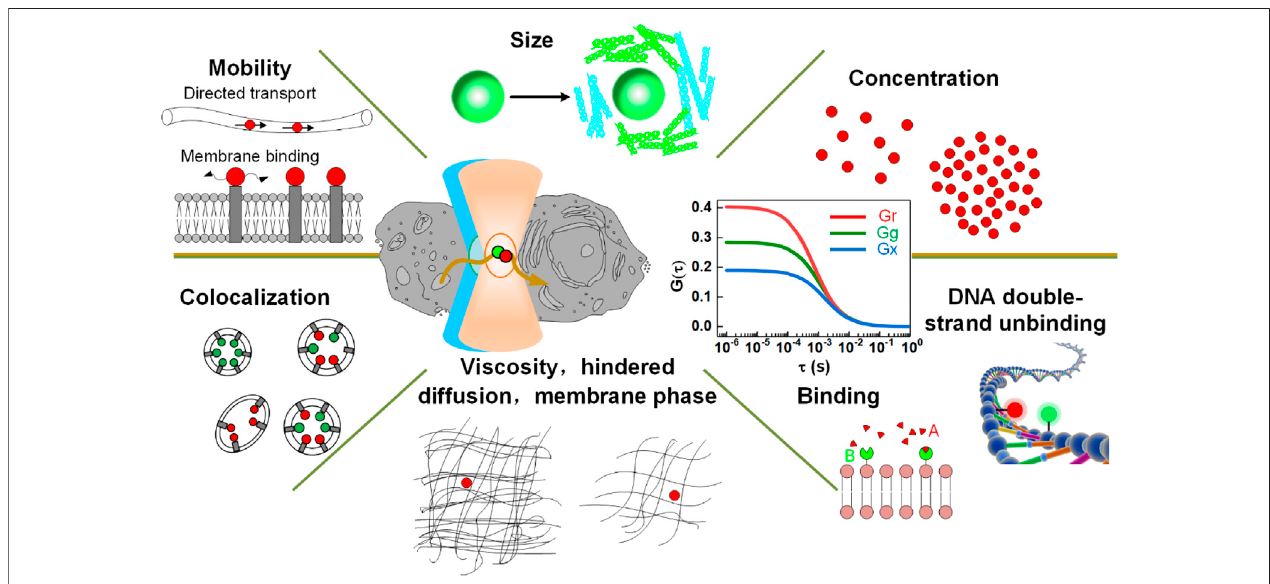
FIGURE 12 | Applications of FCS. Adapted from Ref.